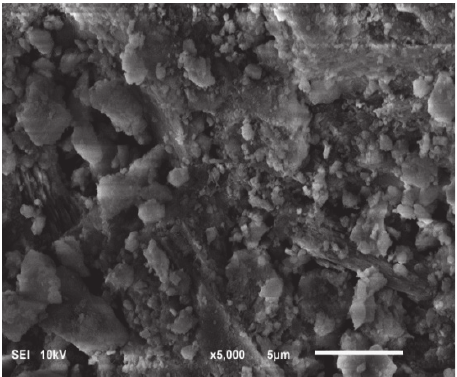
Figure 13: SEM images of Al 2 O 3 .